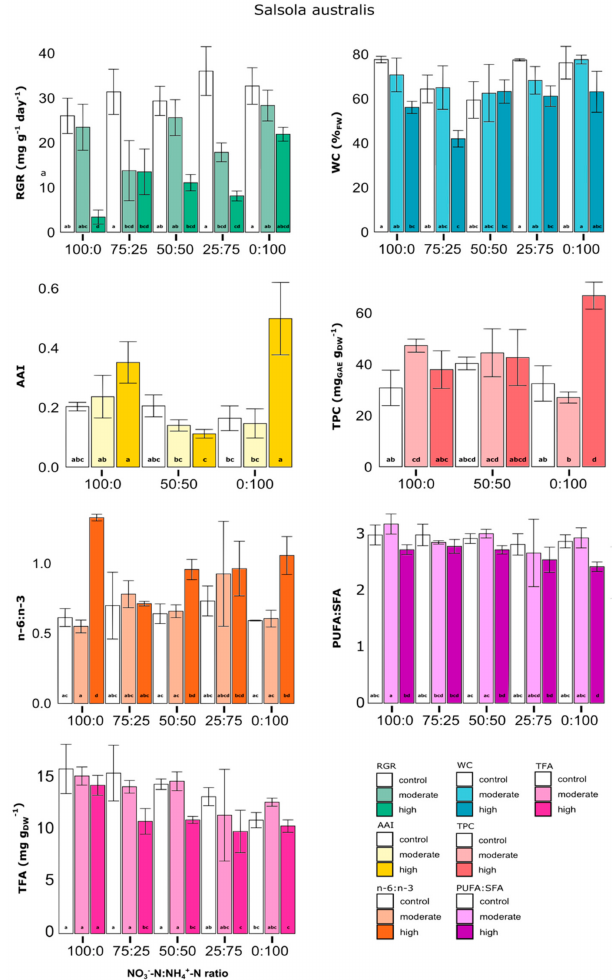
Figure 1. Multiple comparisons of relative growth rate (mg g − 1 day − 1 ), water content (% FW ), antioxidant activity index (AAI), total phenolic compound (TPC) content (mg GAE g DW − 1 ), total fatty acid (TFA) content (mg g DW − 1 ), ratio of polyunsaturated on saturated fatty acids (PUFA:SFA) and ratio of omega 6 on omega 3 fatty acids (n − 6:n − 3) in Salsola australis, between combined treatments of salinity and N-ratio in irrigation water. For each variable, values with the same letters are not significantly different between treatments ( p < 0.05). Data are mean ± SD ( n =